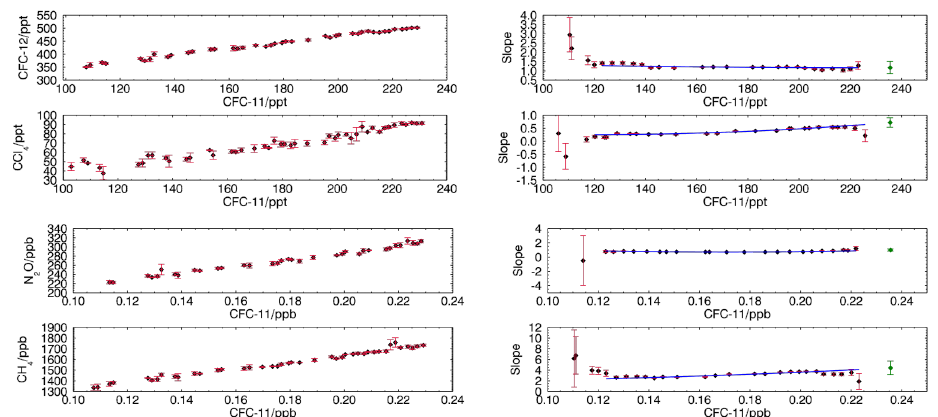
Figure B14 Correlations between the volume mixing ratios of CFC-12, CCl 4 , CH 4 and N 2 O and CFC-11 for the data from the southern hemisphere during the stratospheric summer of 2009. Left panels: The mean correlation profile. Each point represents the mean of the VMR in a window of 2 ppt of CFC-11. The error on these points is the standard deviation of the data within each 2 ppt window. Right panels: The local slope of data in an 80 ppt of CFC-11 window. The error on the points is the fitting error of this fit. The blue line is a second degree polynomial fit to the local slopes. The green point is the extrapolated slope at the tropopause.